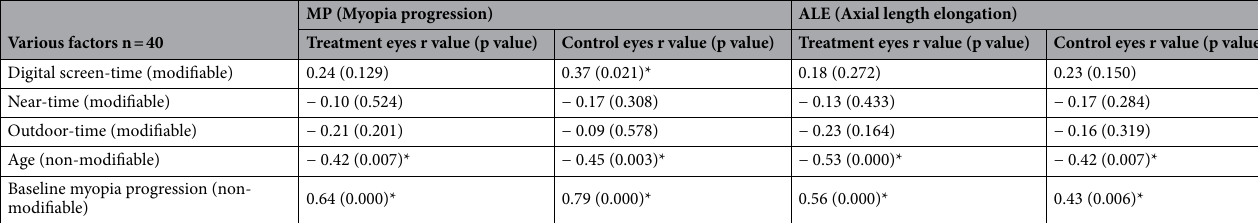
Table 3. Correlation of MP and ALE of treatment and control eyes in all 40 children. *p value of statistical significance <